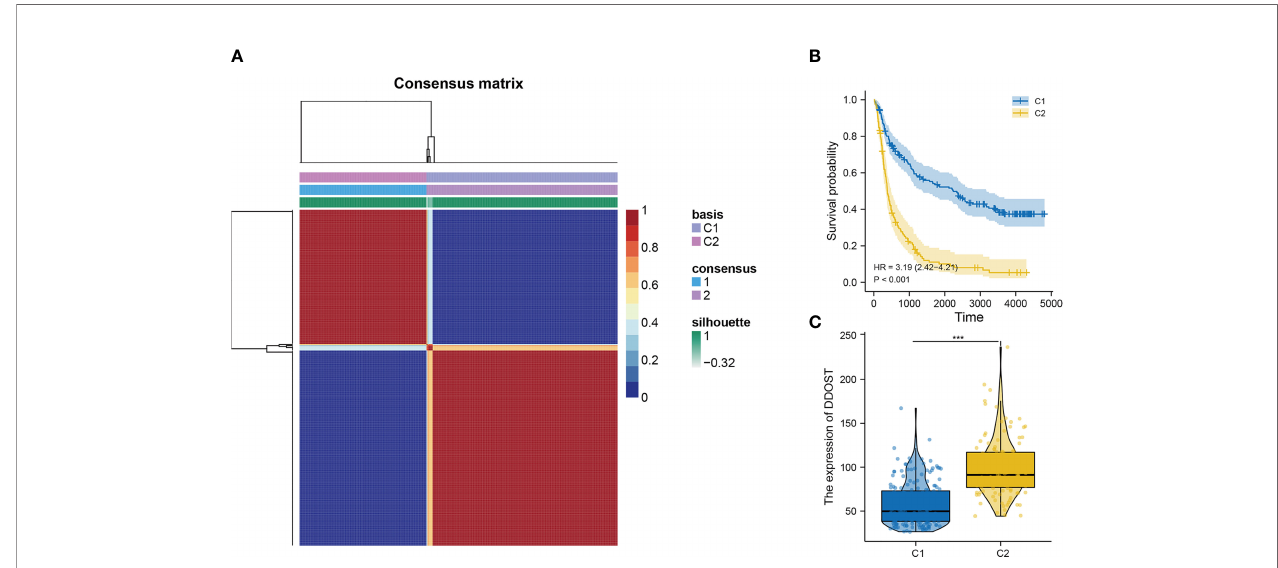
FIGURE 10 | The relationship between DDOST and tumor immune in fi ltration was analyzed by NMF cluster analysis of glioma patients with immune-related genes. (A) According to the cophenetic value and the expression of immune-related genes, glioma patients were divided into two clusters, C1 and C2. (B) The survival curve was used to analyze the survival difference between C1 and C2 groups. (C) The expression differences of DDOST in C1 and C2 clusters were compared. *** p <